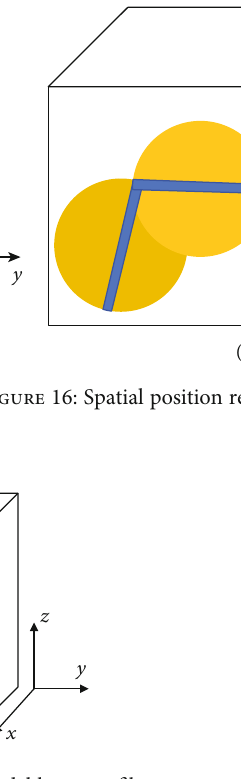
Figure 18: Front view diagram of the relationship between fi